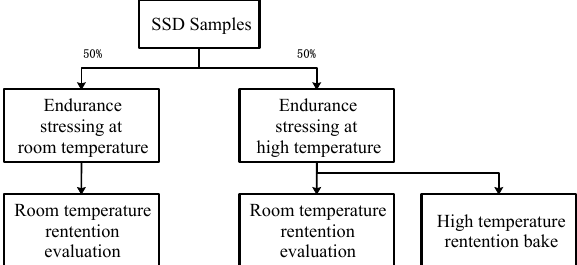
Figure 2. Simplified JESD218 endurance test. The “Endurance stressing at room temperature” is the one that we